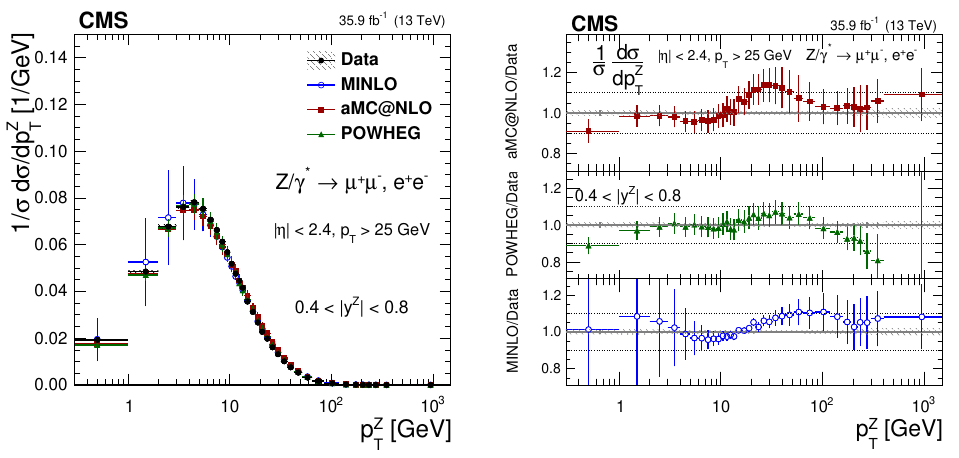
Figure 16 . The measured normalized cross sections (left) in bins of p Z region. The ratios of the predictions to the data are also shown (right). The shaded bands around the data points (black) correspond to the total experimental uncertainty. The measurement is compared to the predictions with MadGraph 5 a mc@nlo (square red markers), powheg (green triangles), and powheg - MINLO (blue circles). The error bands around the predictions correspond to the combined statistical, PDF, and scale uncertainties.